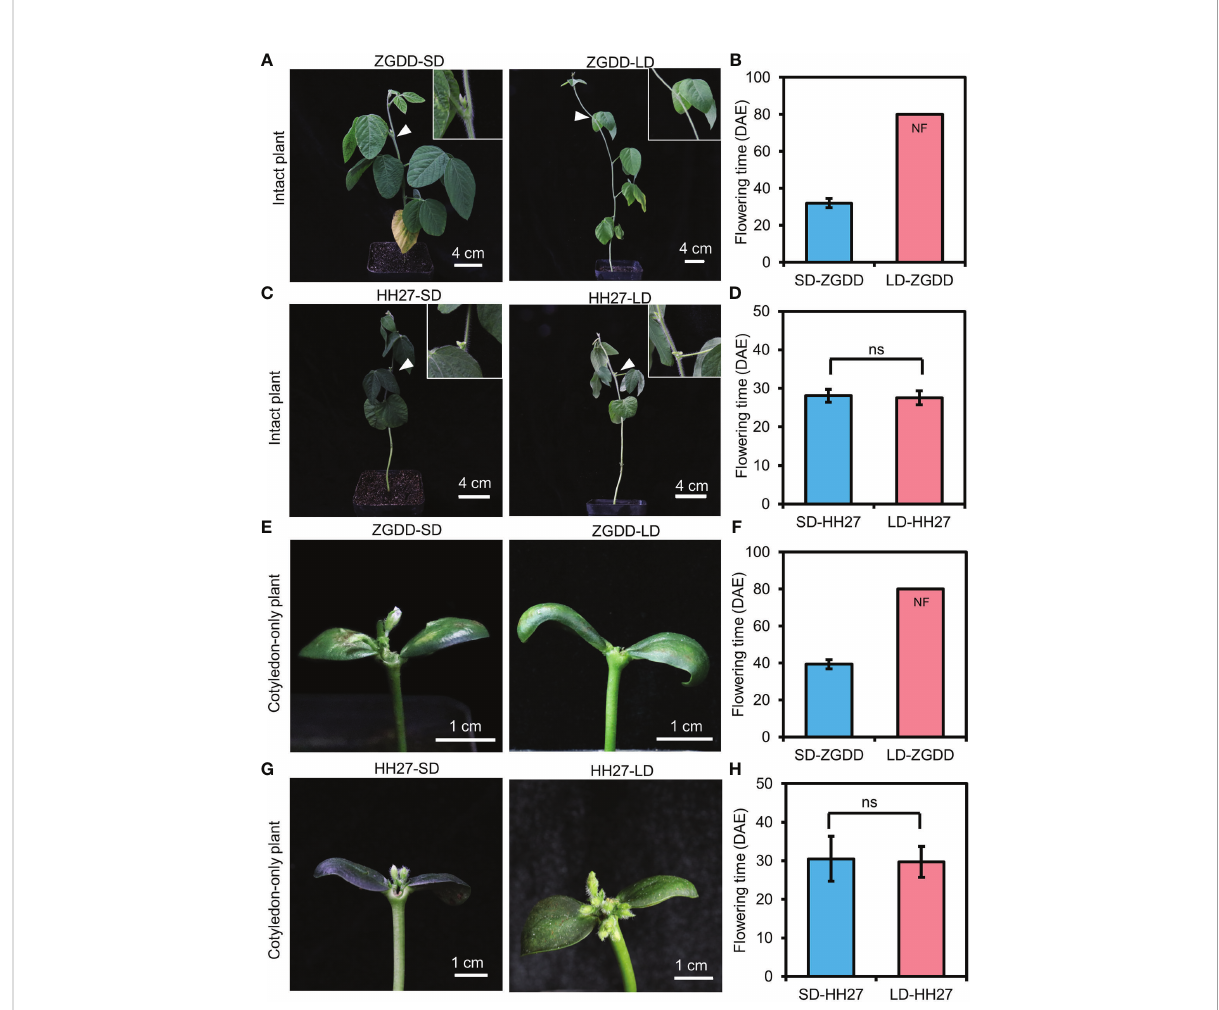
FIGURE 2 The fl owering time of cotyledon-only and intact plants. (A, C) The fl owering phenotype of Zigongdongdou (ZGDD; A ) and Heihe27 (HH27; C ) intact plants under short-day (SD, 12 h light/12 h dark) and long-day (LD, 16 h light/8 h dark) conditions. A close-up view (white arrows) of the fl oral bud and none fl oral bud is shown in the top right. (B, D) The fl owering time of ZGDD (B) and HH27 (D) intact plants under SD and LD conditions. (E , G) The fl owering phenotype of ZGDD (E) and HH27 (G) cotyledon-only plants (COPs) under SD and LD conditions. (F, H) The fl owering time of ZGDD (F) and HH27 (H) COPs under SD and LD conditions. NF means no fl owering during the experiment. Fifteen plants were calculated (B) , (D) , (F) , and (H) . DAE indicates the days after emergence. Error bars indicate the standard deviation. ns means not signi fi